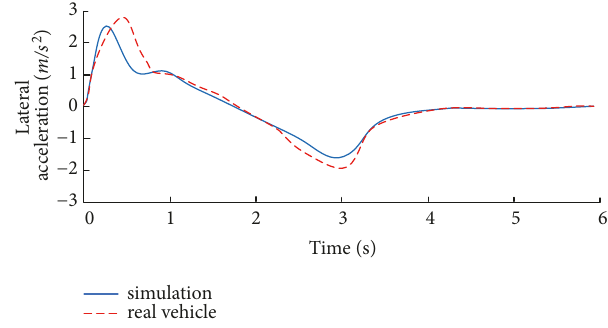
Figure 16: Vehicle lateral acceleration